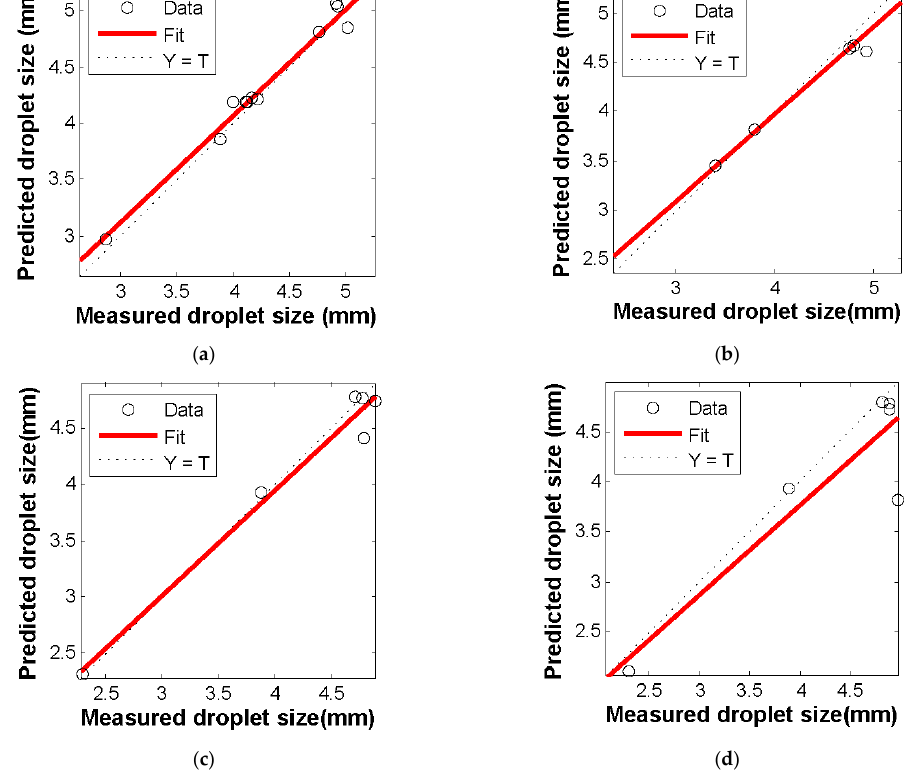
Figure 3. A graphical comparison of the measured versus predicted droplet size diameter for different 4, 5 and 6 mm. ( a ) 4 mm nozzle size; ( b ) 5 mm nozzle size; ( c ) 6 mm nozzle size; ( d ) 7 mm nozzle size. Table 2. Indices of the different orifice shapes in predicting droplet